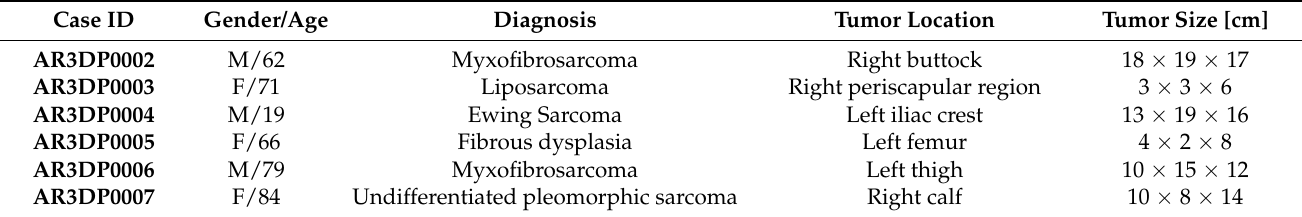
Table 1. Patient demographics involved in this study.